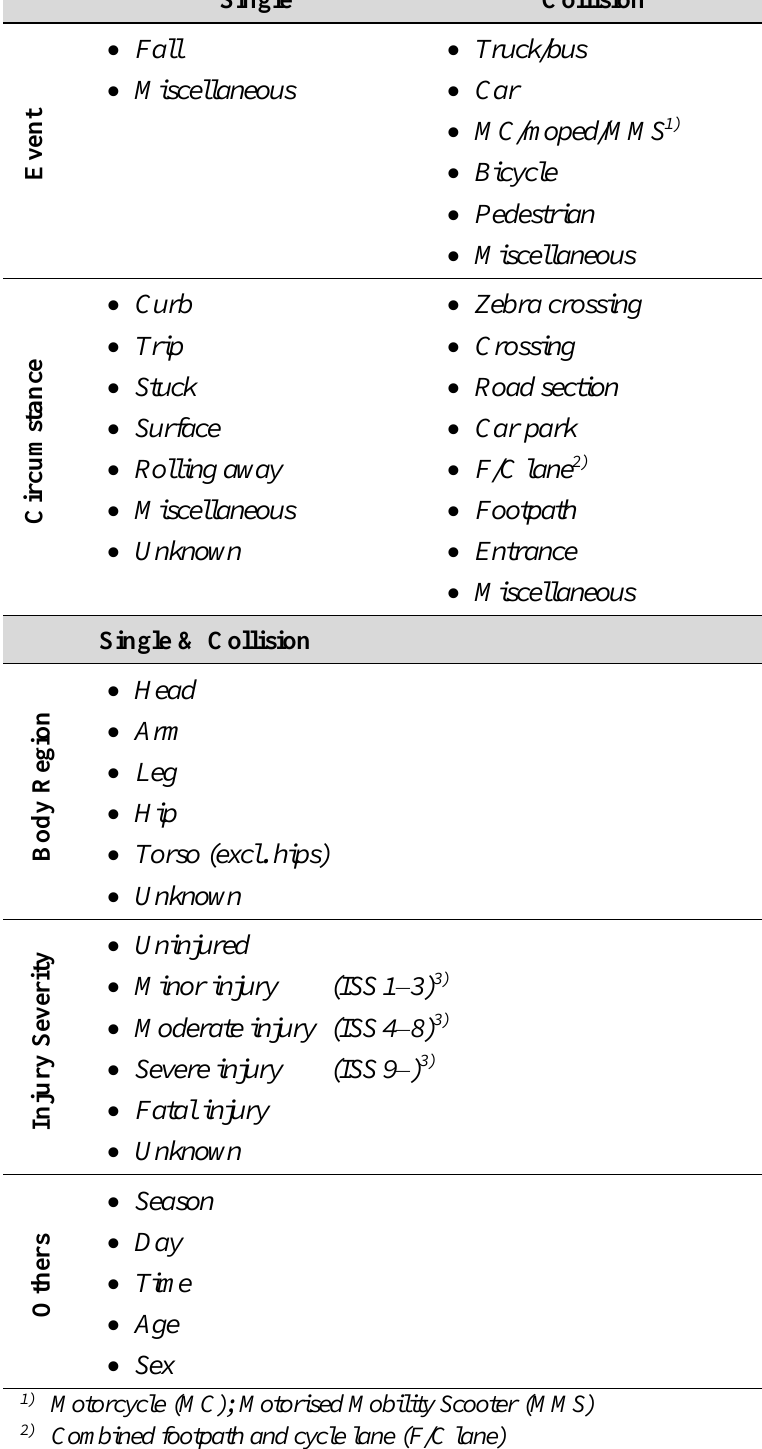
Table 1. Classification of accidents involving rollator